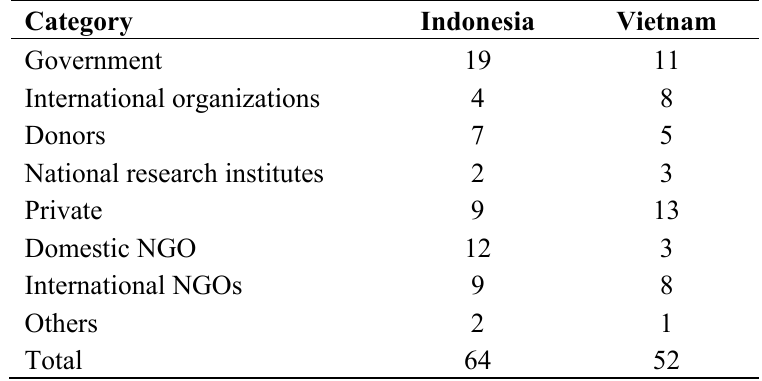
Table 3. Policy actors who participated in the study, by organization